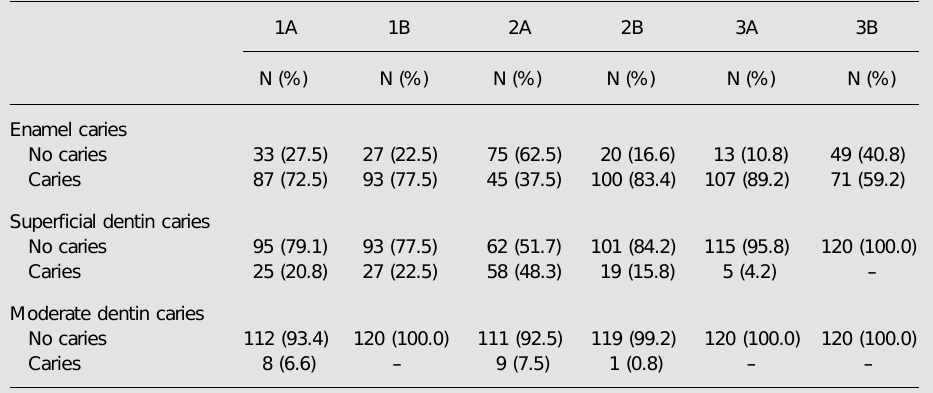
Table 1. Distribution of caries in 720 rat teeth (120 teeth per group) subjected to three types of diet for 30 or 60